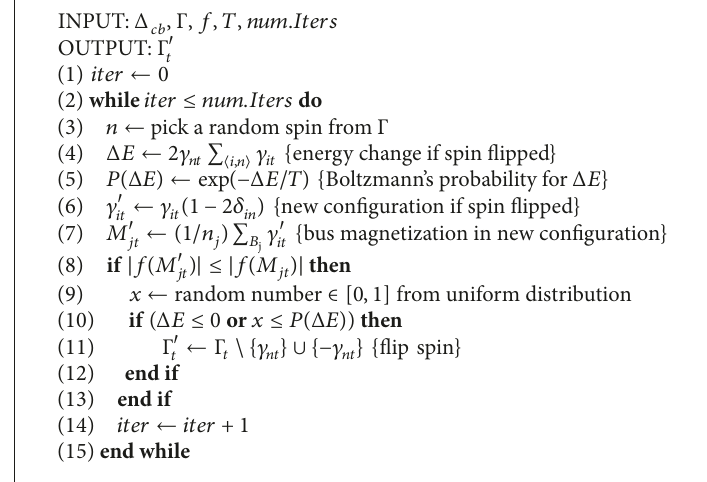
Algorithm 1: Constrained Metropolis-Hastings (CMH).